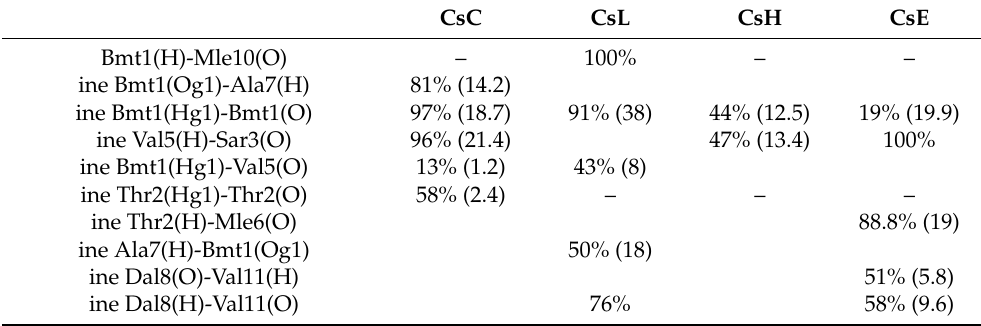
Figure 5. ( a , c ) Evolution of some hydrogen bonds in cyclosporins. ( b ) Correlation between the O–H distance and O–H–N angle in the case of bimodal behaviour, when the hydrogen bond disrupts and appears again. ( d ) Example of the autocorrelation for the hydrogen bond existance function. Table 3. Appearance of hydrogen bonds during the simulation. The left column shows the interacting atoms (O is the carboxyl oxigen; H, amide proton; Hg and Og are atoms in the γ -positions). The table shows which H-bonds are stable: relative duration of their existence (%) during the simulation and the length of the longest detected existence period (ns, in